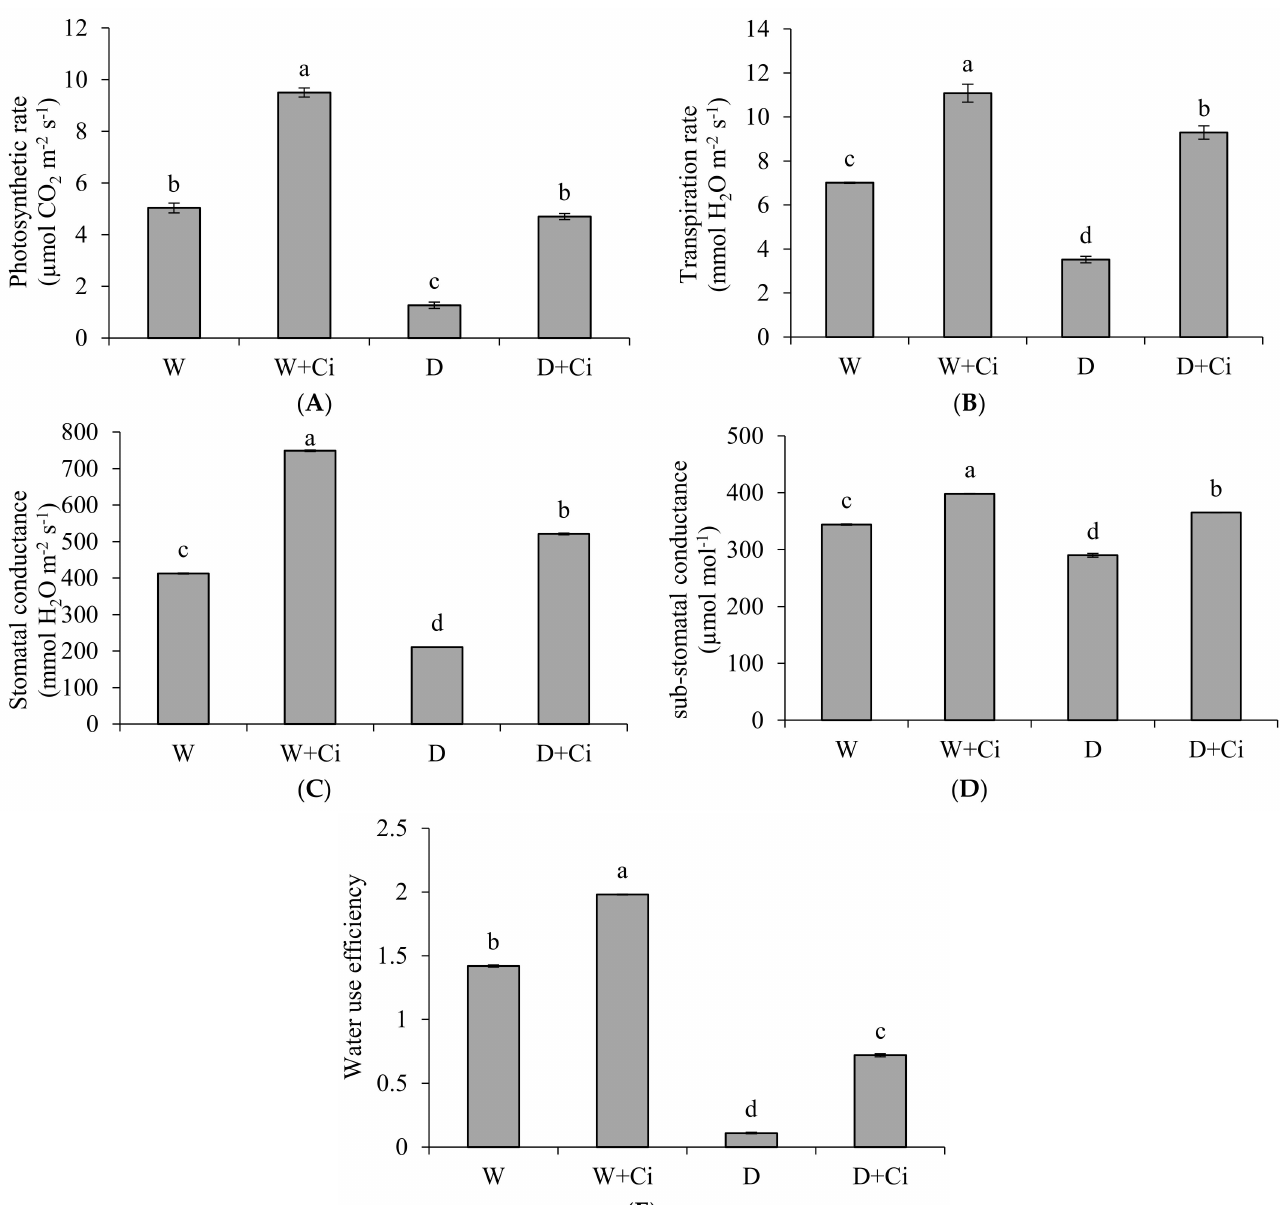
Figure 2. ( A ) Photosynthetic rate; ( B ) transpiration rate; ( C ) stomatal conductance; ( D ) sub-stomatal conductance; and ( E ) water use efficiency of Calendula officinalis after foliar application of chitosan (7.5 mg L − 1 ) weekly at 100% and 60% FC. Letters above the bars represent significant differences at p < 0.05 according to LSD test. W, normal conditions (100% FC); W + Ci, chitosan under normal conditions; D, drought stress without chitosan (60% FC); D + Ci, drought stress with chitosan (each mean consists of 3